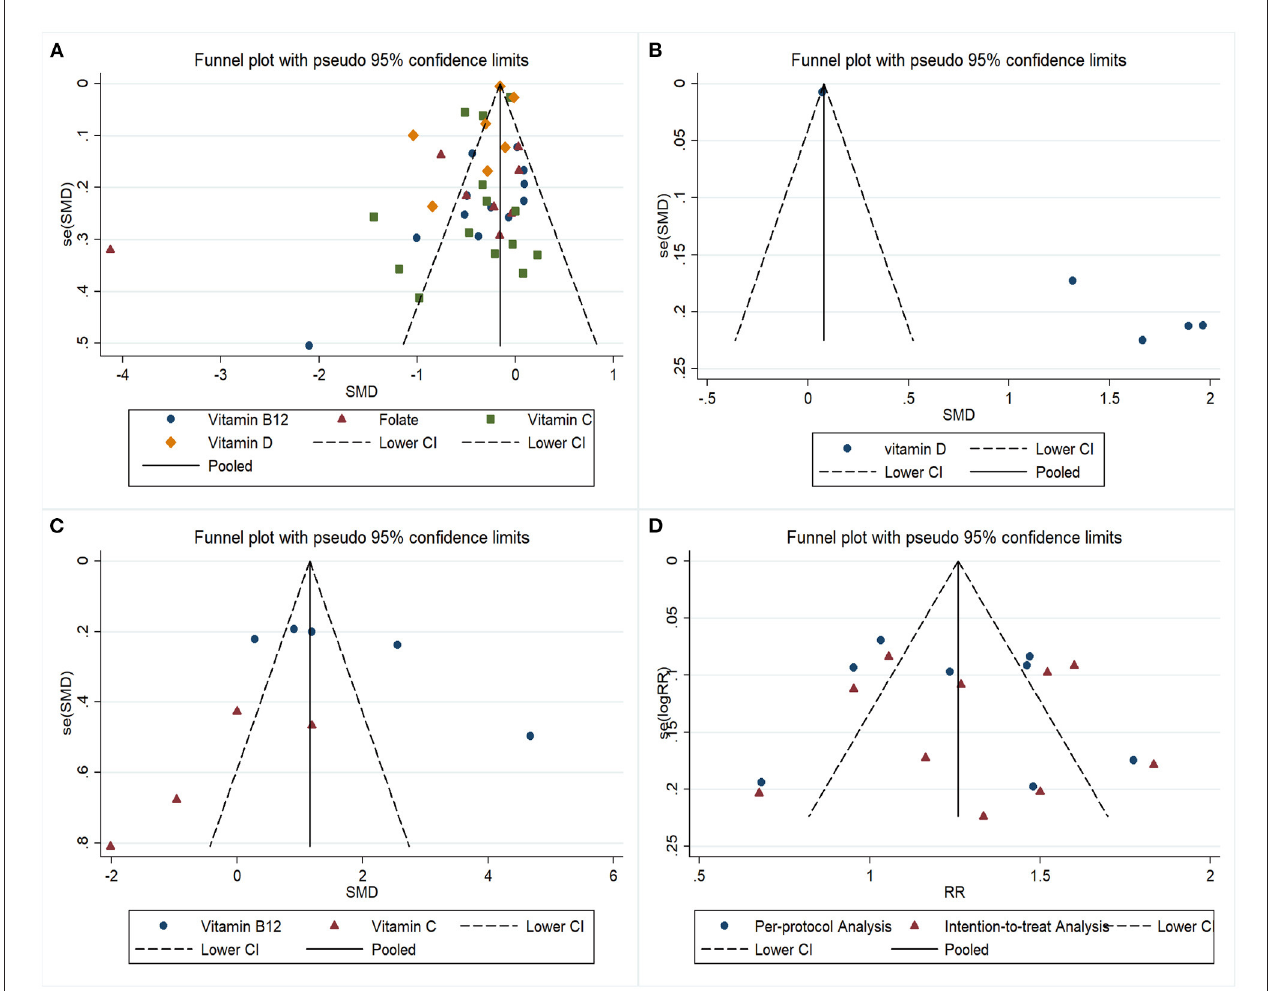
FIGURE 3 | Funnel plots of the meta-analysis on relationships between H. pylori and vitamins: (A) Comparison of serum vitamin levels between H. pylori - positive and H. pylori - negative patients; (B) Comparison of serum vitamin levels between H. pylori successful and failed eradication patients; (C) Comparison of serum vitamin levels before and after successful H. pylori eradication therapy; (D) Effect of vitamin supplements on the H. pylori eradication